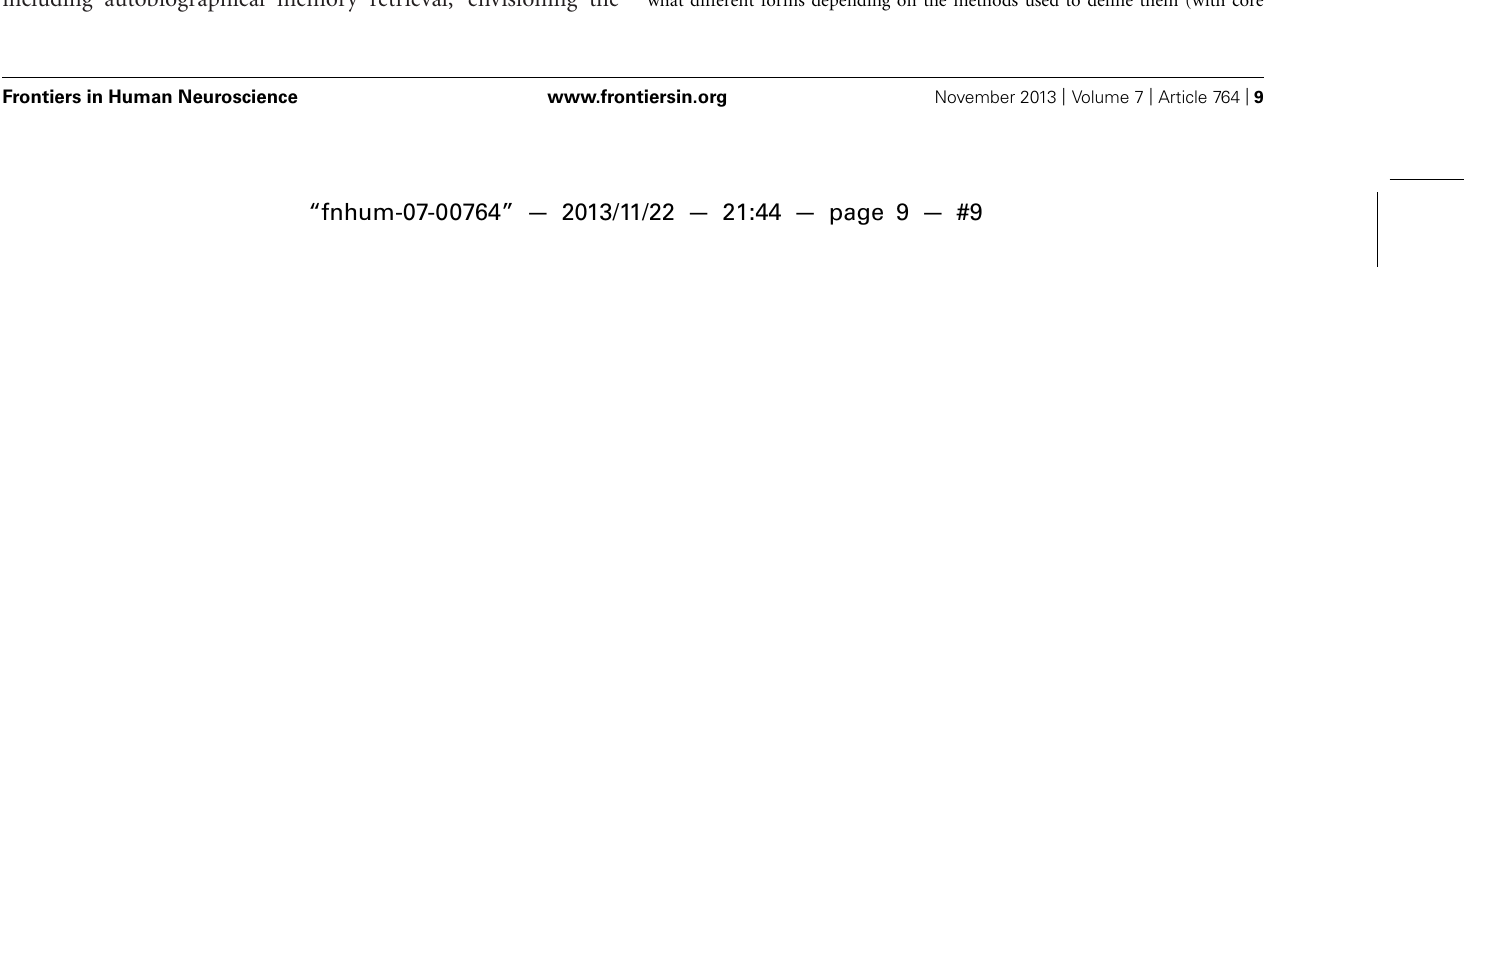
reported immersion ratings from the training session (error bars depict SEM across participant condition means) (C) shared neural activity revealed by the conjunction analysis in the amygdala and